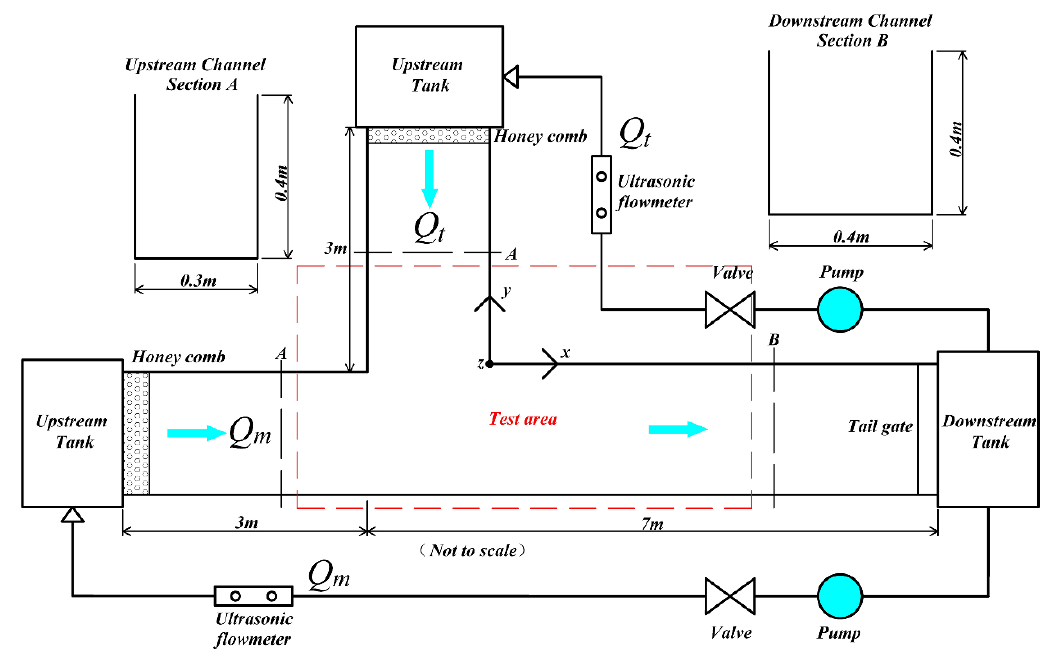
Figure 1. Schematic diagram of the experimental device: a 90-degree confluence channel flume. Two terrain cases and three flow field cases were considered. D 50 = 0.95 mm, and one 10 cm layer of sand was evenly spread on the bottom of the entire channel to simulate a natural riverbed. The water level was controlled at 26 cm by the tail water valve. The discharge ratio of natural rivers is in the range of 0.27–0.68 and it was approximately 0.4 and 0.6 in this